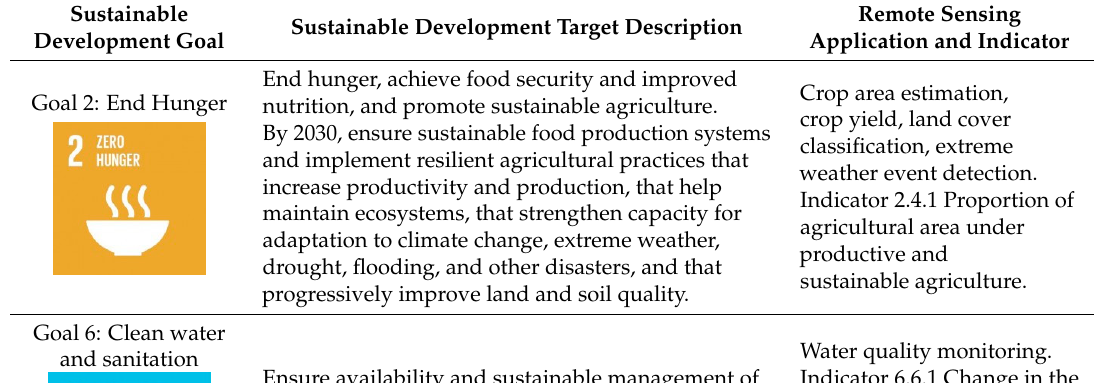
Table 1. Remote sensing data, as used to measure UN Sustainable Development